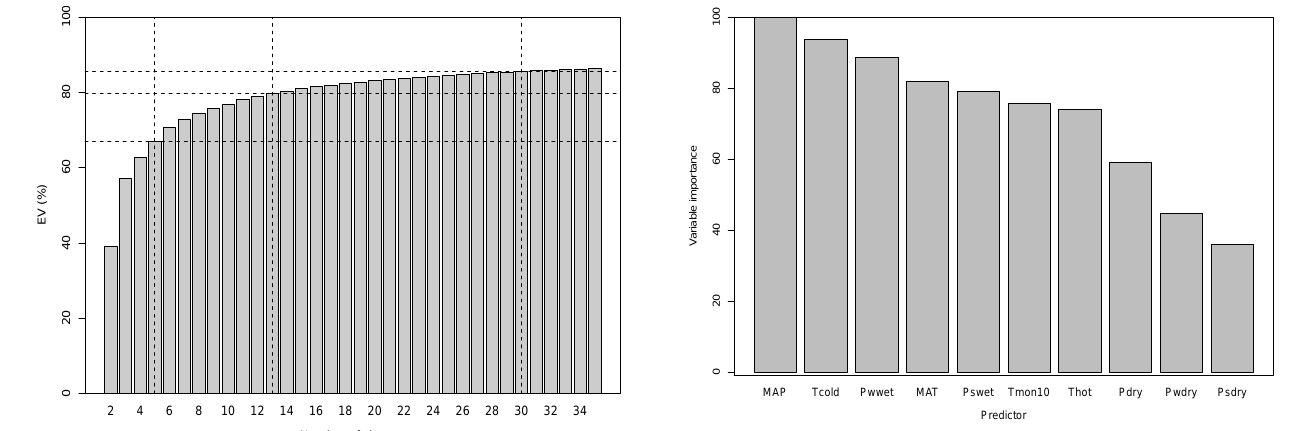
Fig. 3. Combined monthly temperature and precipitation EV for the MRT climate classification (2–35 classes). The 5, 13, and 30 class levels are indicated by dashed lines.